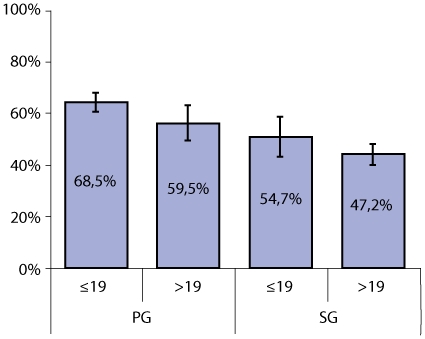
Positive malaria thick films at first antenatal visit in adolescent (≤19 years) and adult (>19 years) primigravidae (PG) and secundigravidae (SG).